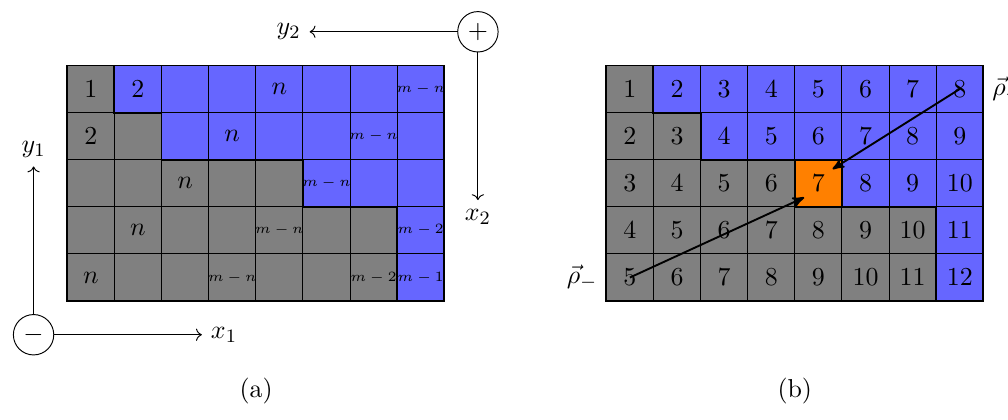
Figure 14 . Diagrammatic depiction of equivariant fixed points on S n,m − n